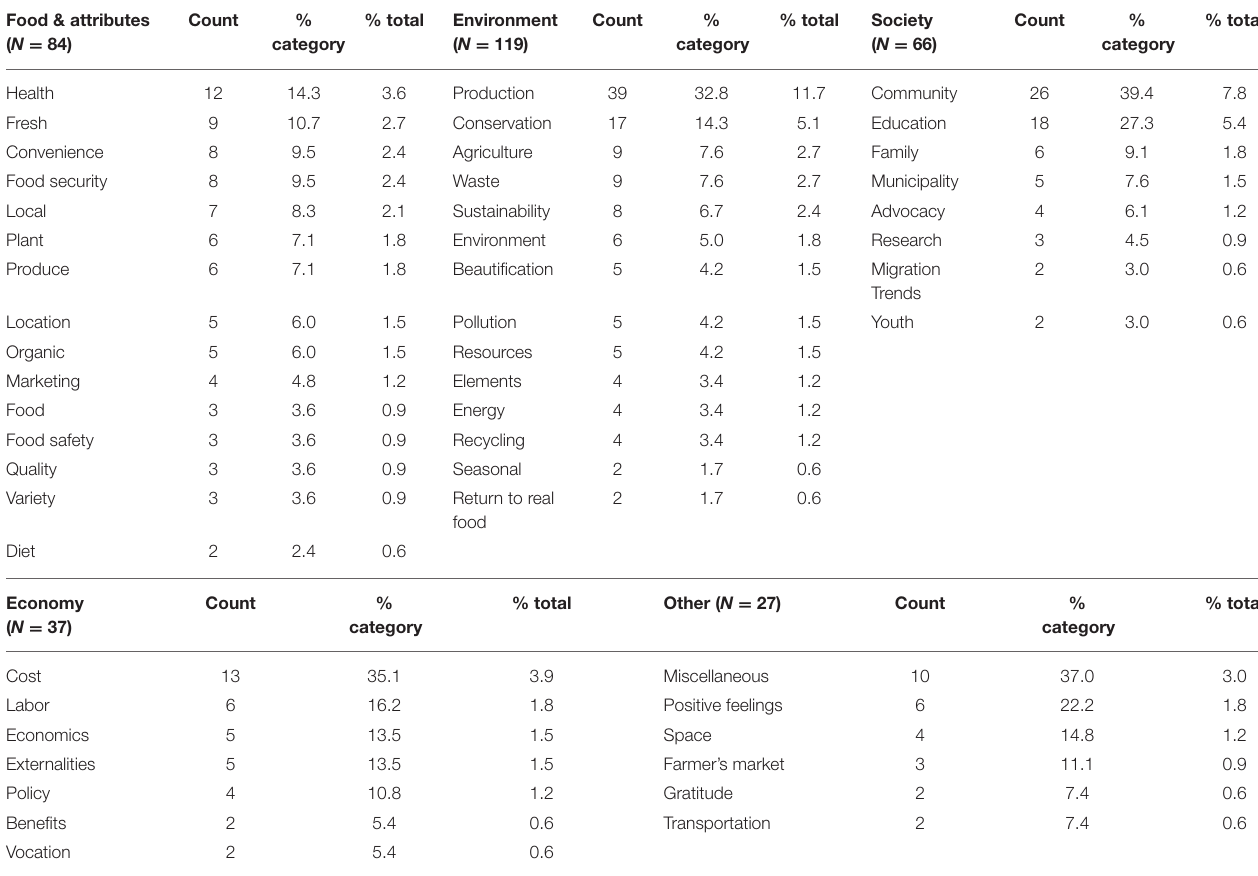
TABLE 3 | Results of concept mapping and content